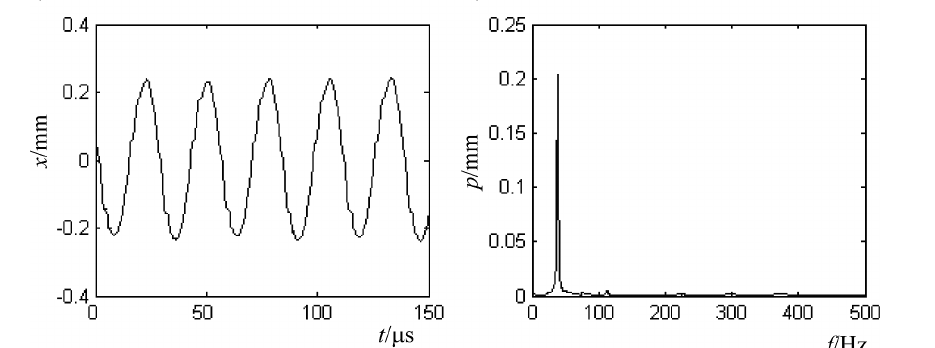
Fig. 12. Rotor kit FEM cell partition.